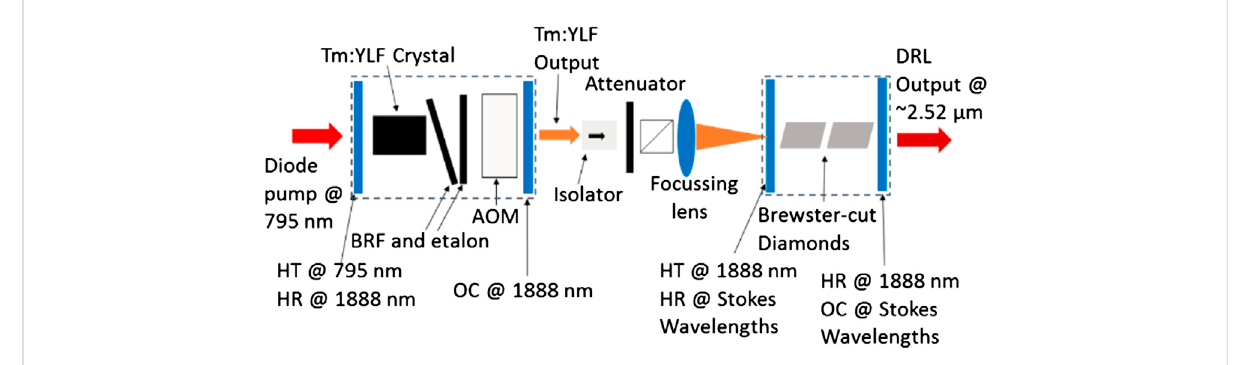
FIGURE 5 Layout of the experimental setup in Ref. [49]. Image originally published in Ref. [49] and reproduced with permission according to the open access licenses © [2019] Optica Publishing Group under the terms of the Optica Open Access Publishing Agreement.